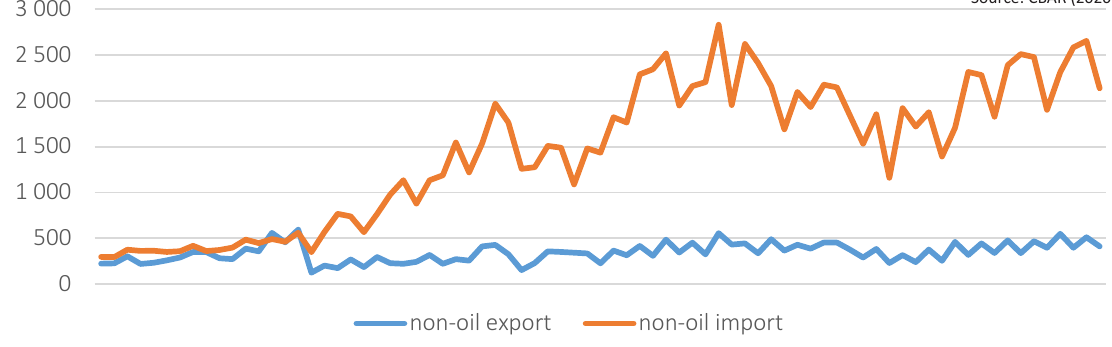
Figure 2. Dynamics of quarterly non-oil